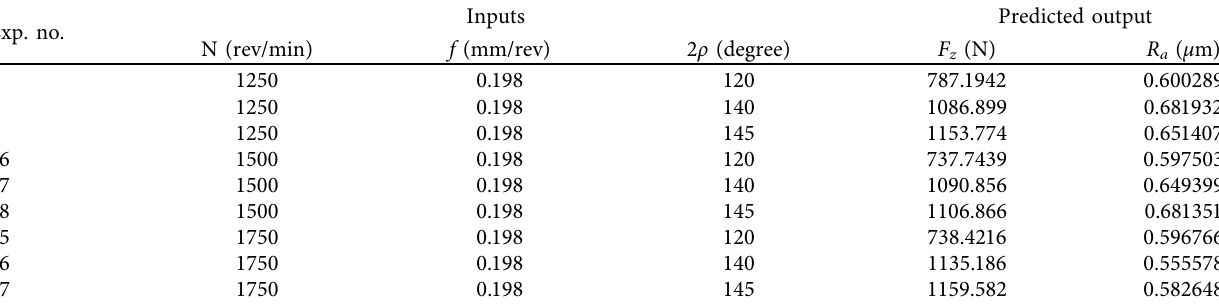
Table 8: FFNN model results for test dataset using the LM algorithm. Exp. no.